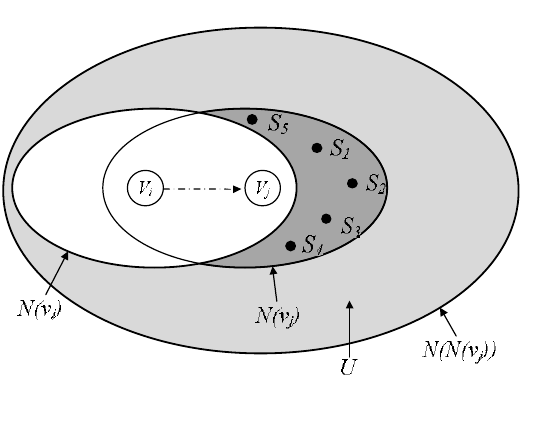
Figure 8. Selective